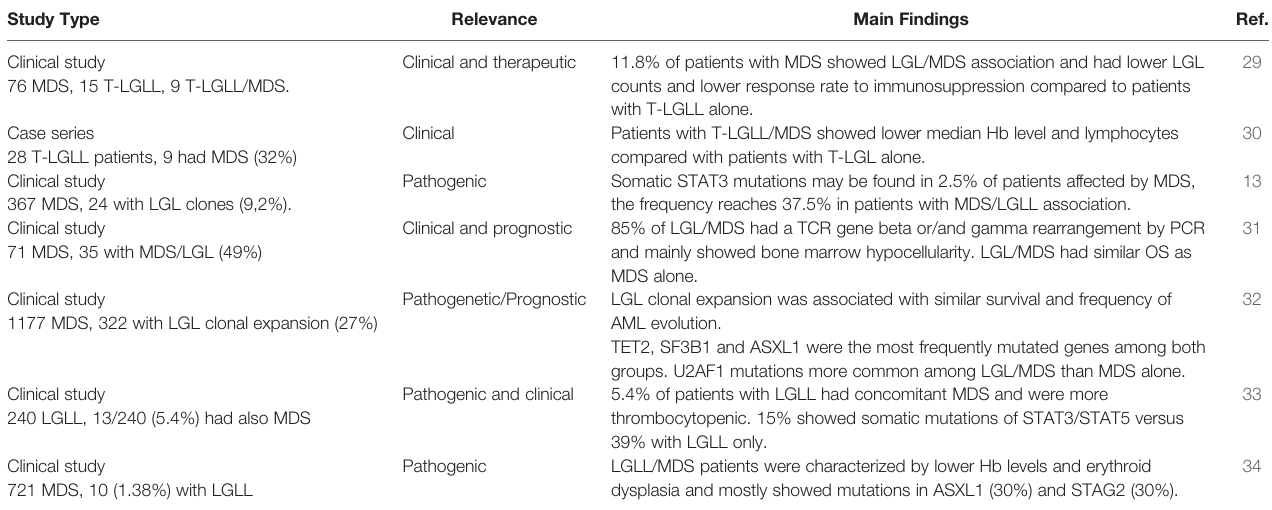
TABLE 1 | Large granular lymphocytes in myelodysplastic